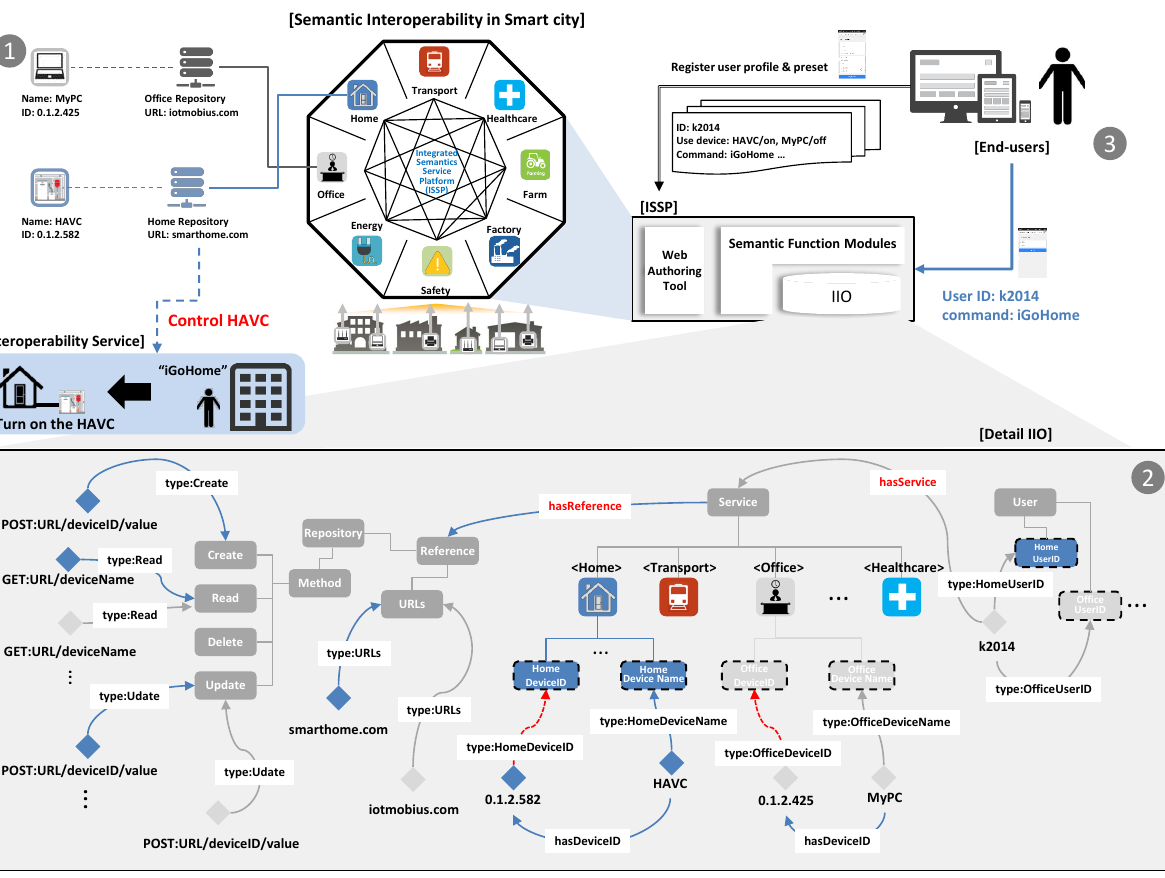
Figure 15. Semantic interoperability for a smart city service